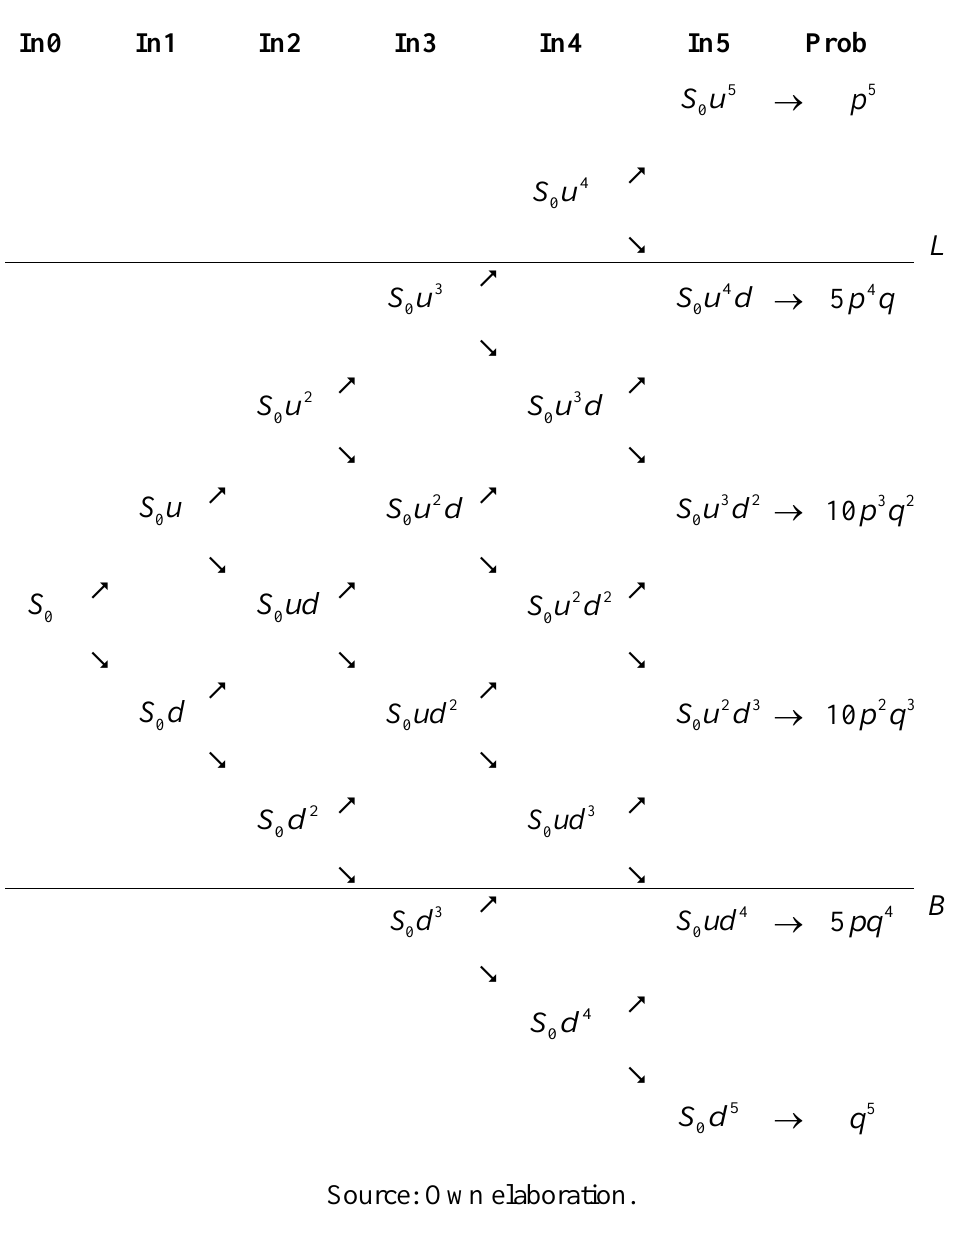
Figure 4: Value of the barrier option cap within 5 periods